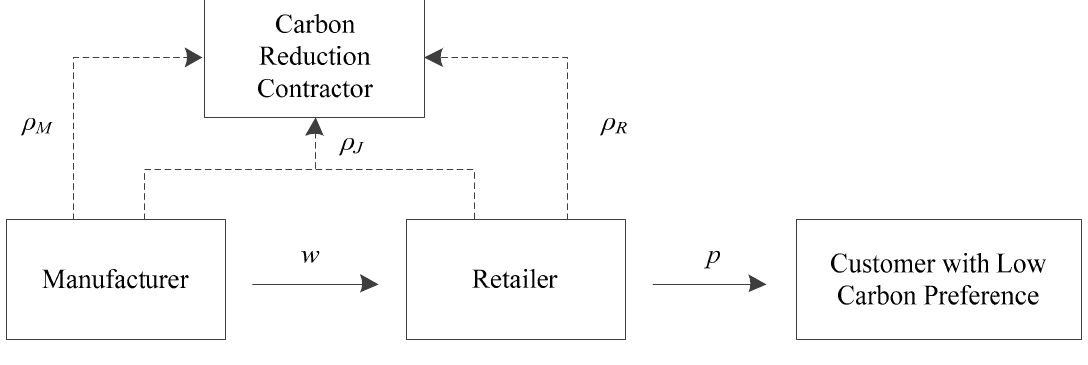
Figure 1. Supply chain structure.